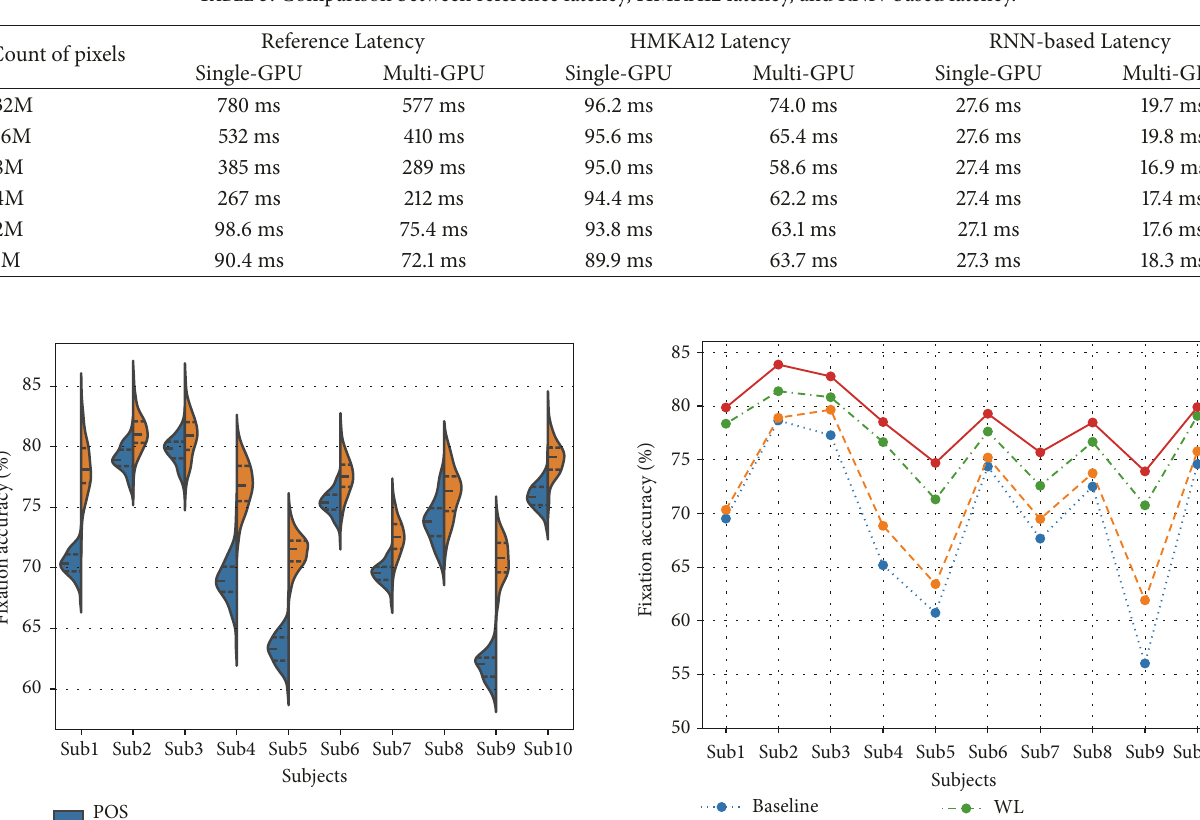
Table 5: Comparison between reference latency, HMKA12 latency, and RNN-based latency.